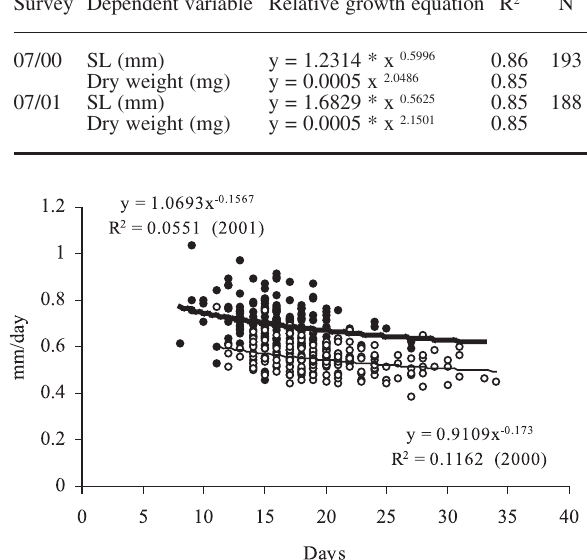
2001.T ABLE 2. – Allometric growth models of SL and dry weight rela- tionship on otolith radius of the anchovy populations from the 2000 and 2001 spawning